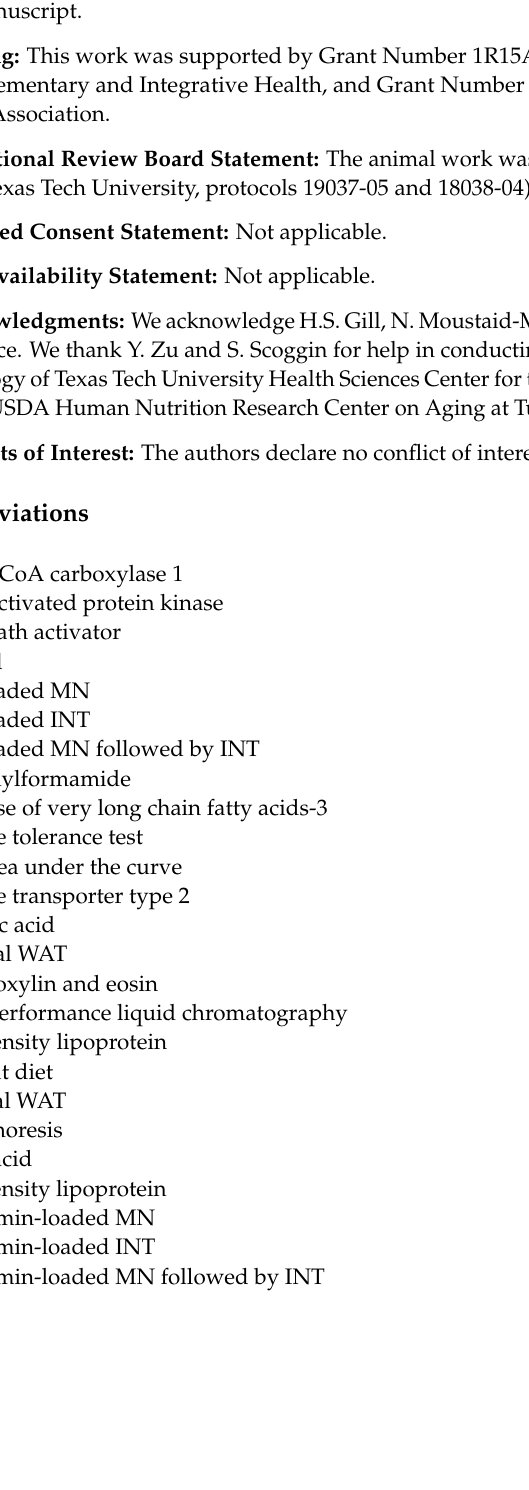
patch release profile. Figure S3: In vitro transdermal delivery of dye using MN and INT. Table S1: Metformin stability in MN patches. Table S2: Primer sequences